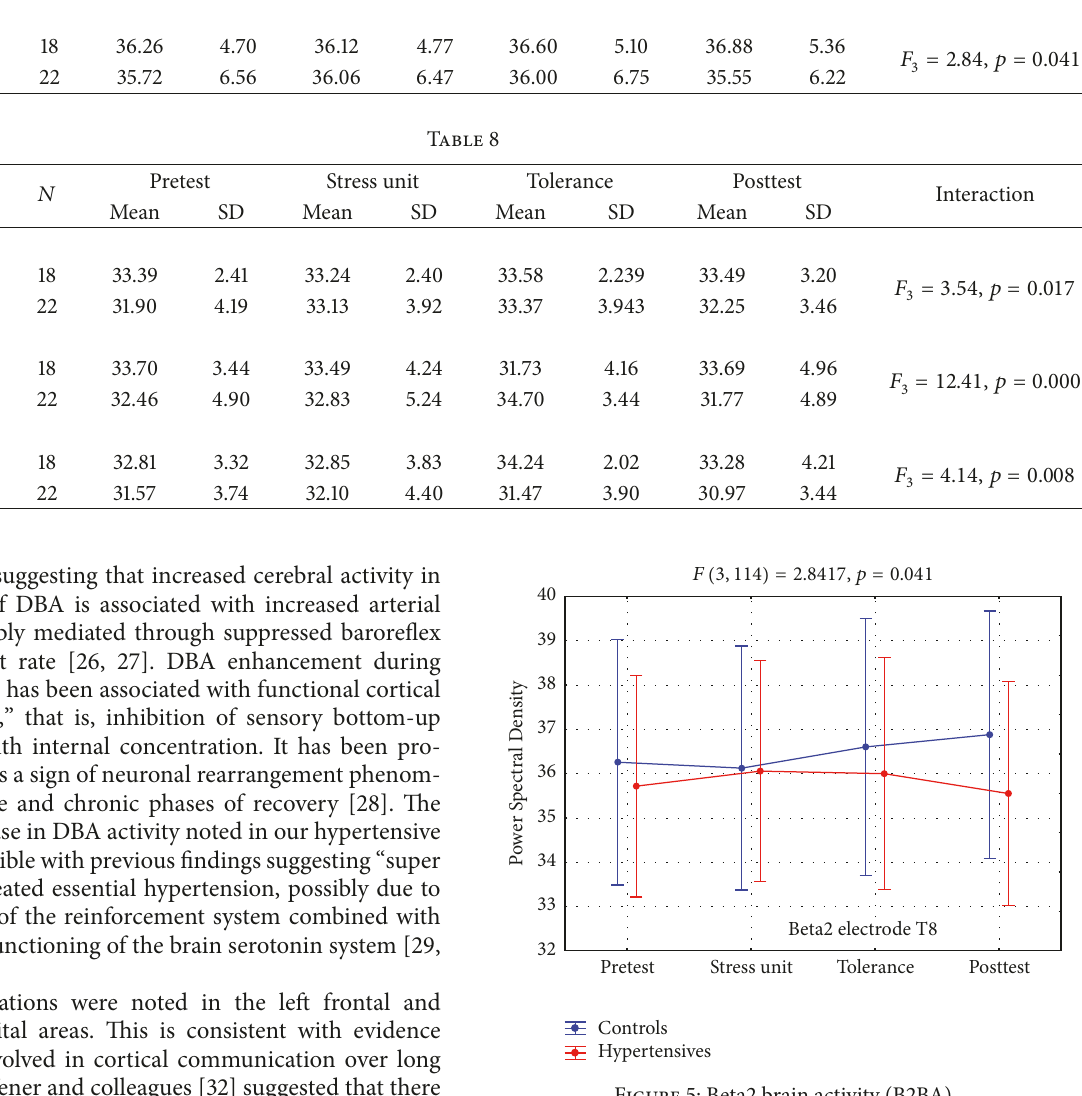
Figure 5: Beta2 brain activity